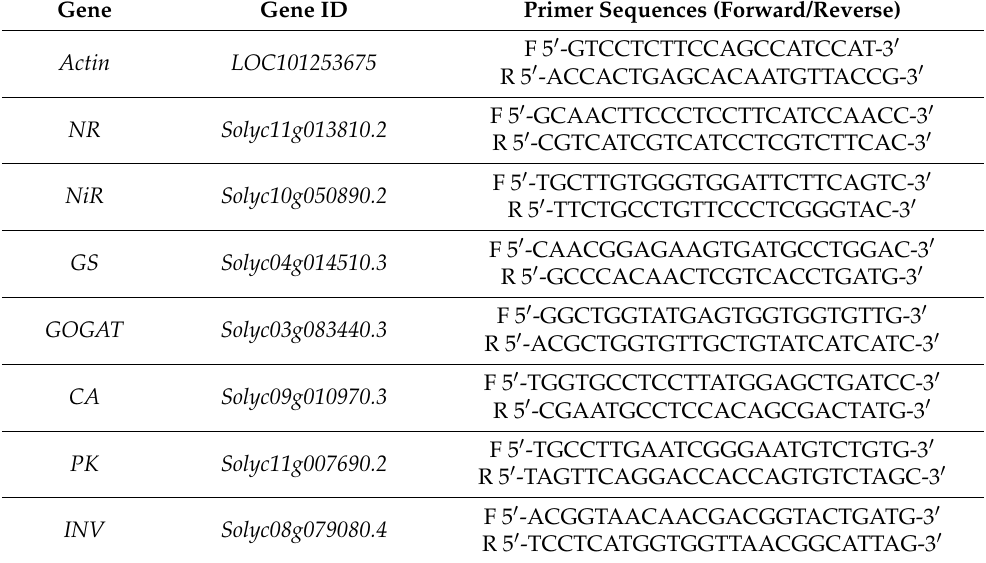
Table 4. Primers used for RT-qPCR analysis.